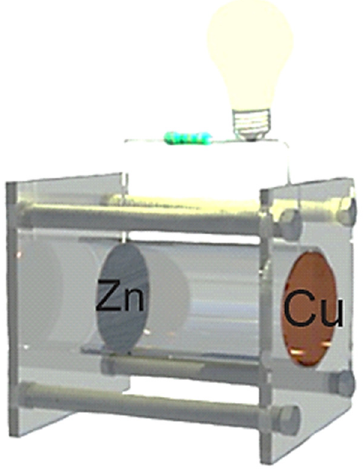
Figure 1. Scheme of single-chamber microbial fuel cell.